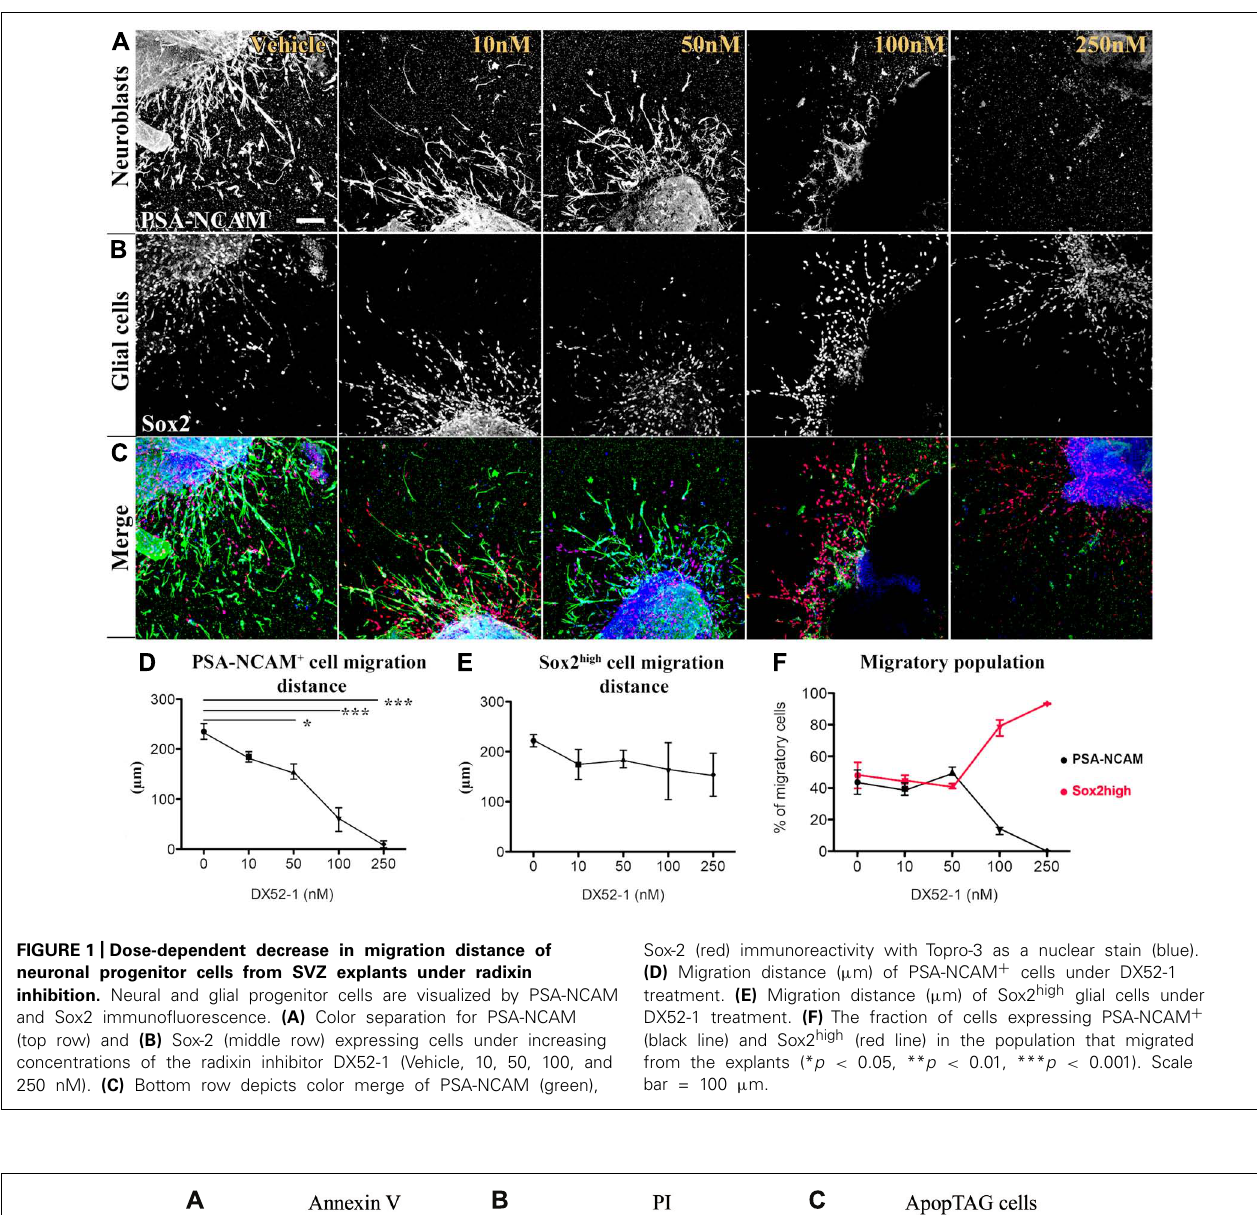
Sox-2 (red) immunoreactivity with Topro-3 as a nuclear stain (blue). (D) Migration distance ( μ m) of PSA-NCAM + cells under DX52-1 treatment. (E) Migration distance ( μ m) of Sox2 high glial cells under DX52-1 treatment. (F) The fraction of cells expressing PSA-NCAM + (black line) and Sox2 high (red line) in the population that migrated from the explants (* p < 0.05, ** p < 0.01, *** p < 0.001). Scale bar = 100 μ m.